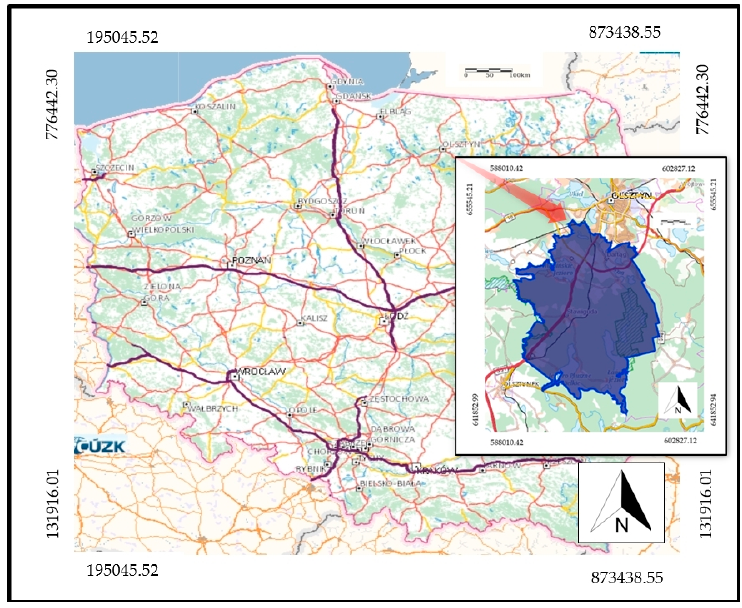
Figure 3. Research area. Source: own study [54].